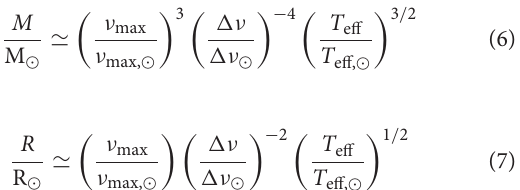
values as adopted in the